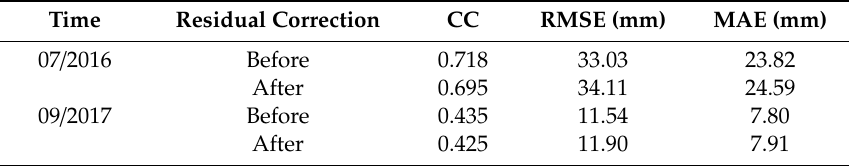
Table 2. Comparison of evaluation metrics before and after residual